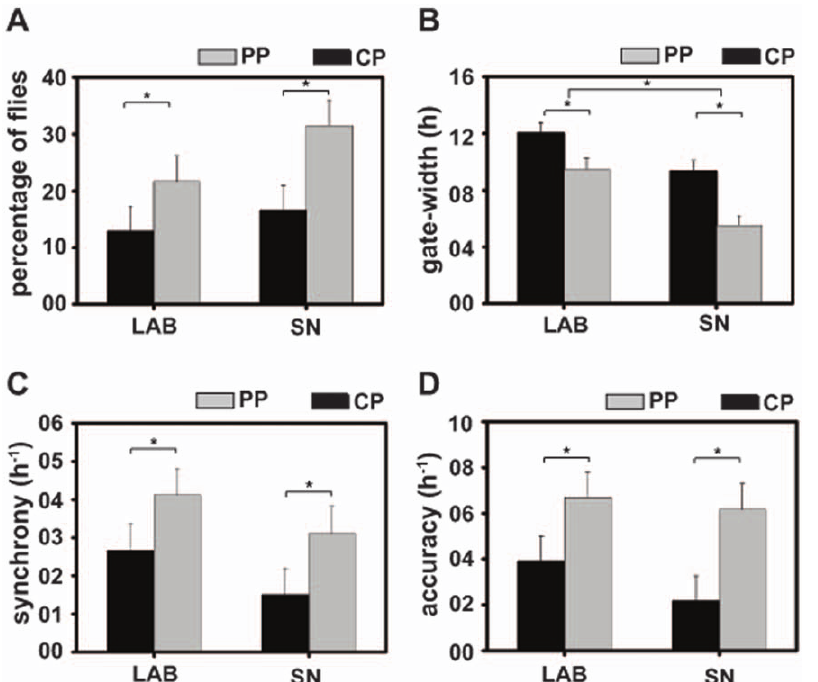
Figure 3. Selected flies in semi-natural (SN) condition emerge in a narrower gate with enhanced accuracy. ( A) Percentage of flies emerged during the selection window (ExT7-8) under laboratory (LAB) and SN. Higher percentage of flies emerges during the selection window under LAB as well as SN. (B) Gate-width of emergence rhythm in selected ( PP ) and control ( CP ) populations. PP flies exhibited narrower emergence gate under SN. (C, D) Synchrony and accuracy of PP and CP flies under LAB and SN. PP flies exhibit greater synchrony and accuracy compared to controls under both conditions. All other details are same as in Figure 2.